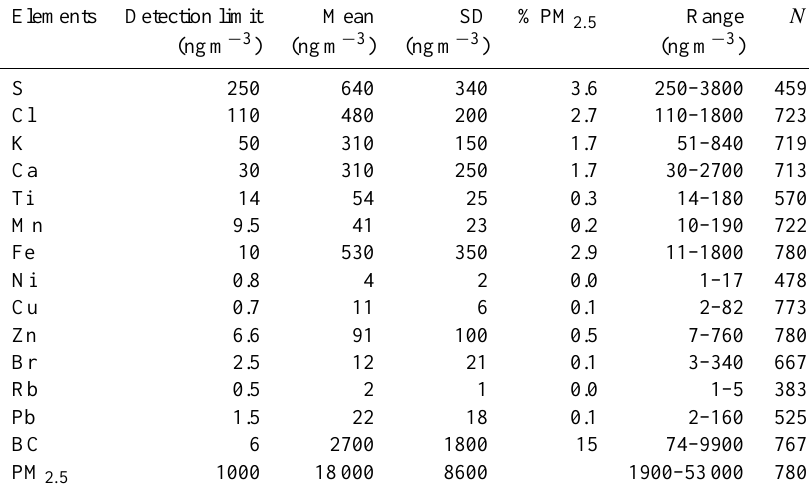
Table 1. Summary of the results from all filter samples for the collection period 22 May 2008 to 30 March 2010 at two sites in Nairobi, Kenya, which include detection limits, range, mean concentrations (ngm − 3 ), standard deviations (SD) and percentage composition (%PM 2 . 5 ) for detected trace elements, BC and PM 2 . 5 . N is the number of valid